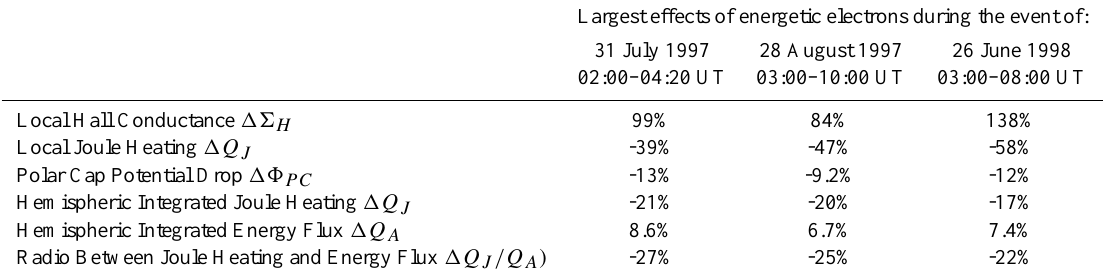
Table 1. We present the largest changes in percent of the different electrodynamical parameters when including energetic electrons derived from the PIXIE data during the three events on 31 July 1997, 28 August 1997, and 26 June 1998. The largest changes in the local values of Hall conductance and Joule heating are found in regions of limited extent, as demonstrated in Fig. 2, Fig. 6, Fig. 9, and Fig. 10. We have excluded values less than 10S and 10mWm − 2 , respectively, to avoid effects caused by statistical uncertainties. Largest effects of energetic electrons during the event